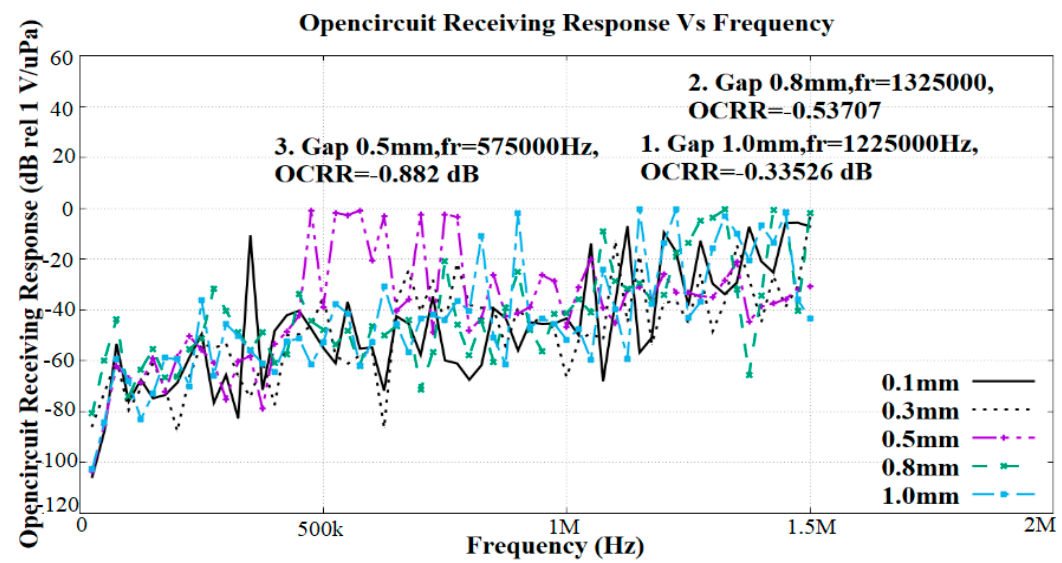
Figure 7. FEA simulation results for the effects of the distance between two electrodes towards in-plane polarization of the PMUT in terms of the open-circuit receiving response (OCRR) vs.